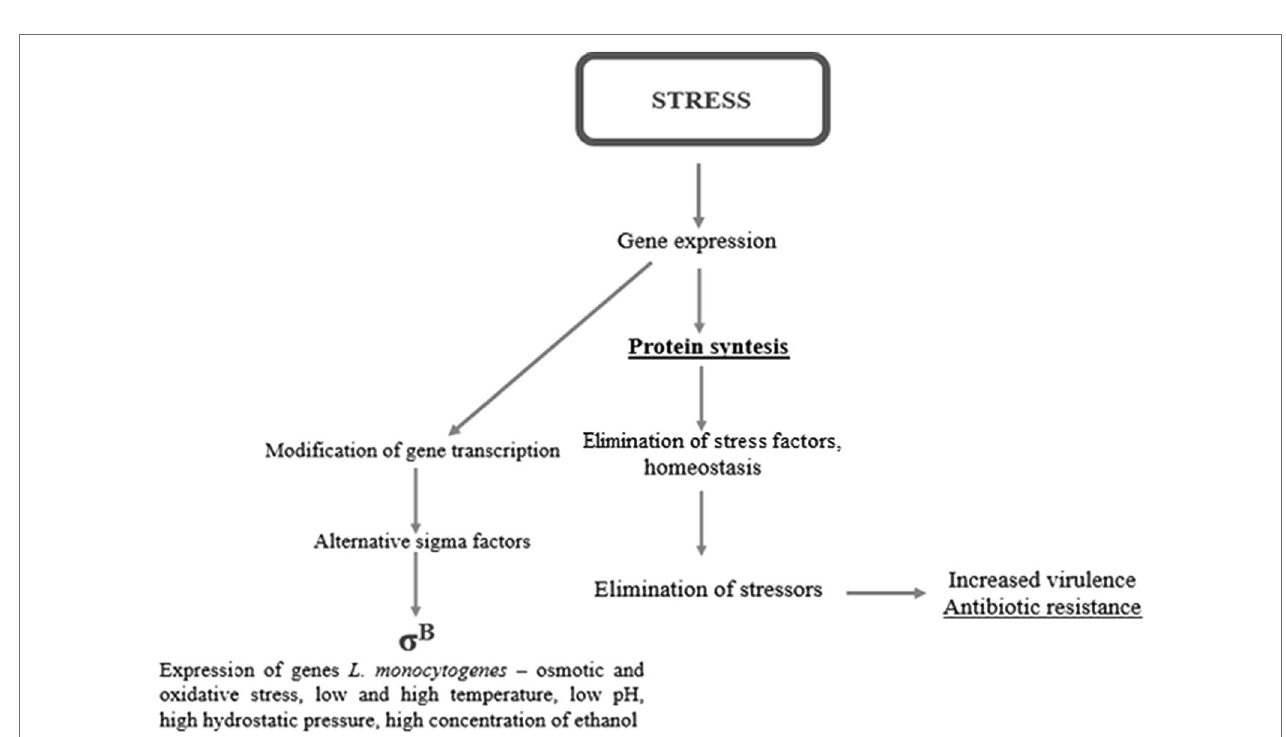
FIGURE 2 | The stress response in L. monocytogenes .